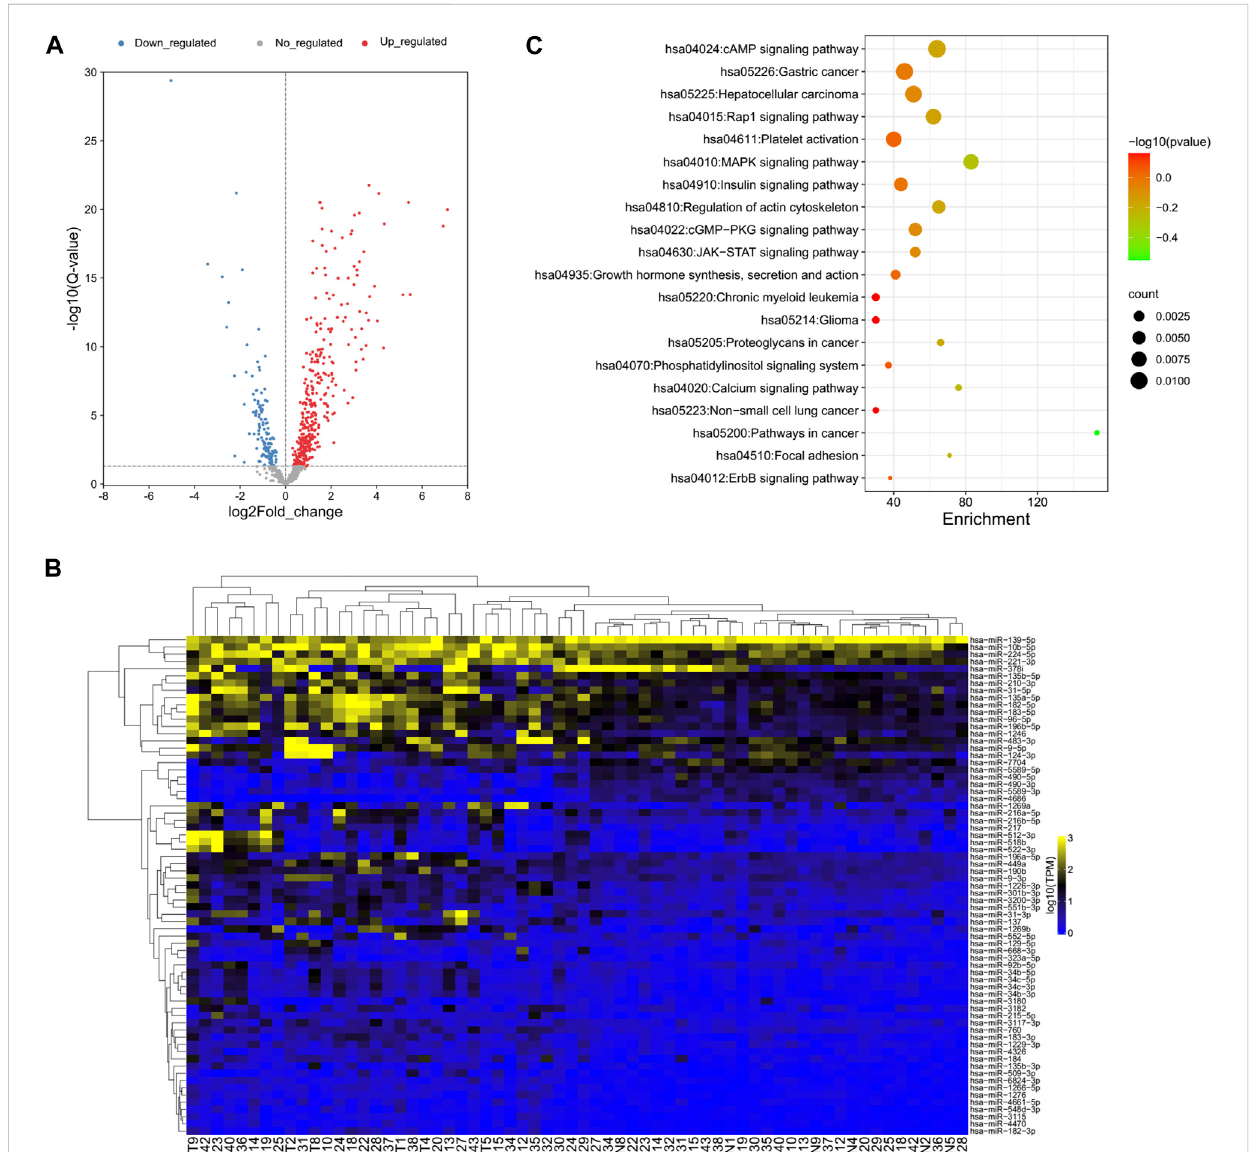
FIGURE 2 Global deep sequencing analysis of miRNAs from HCC tissue and normal adjacent tissue specimens. (A) Volcano plot of log2fold changes and -log10 (adjust p -value) differentially regulated miRNAs in HCC tissue and adjacent tissue specimens. Differentially expressed miRNAs were identi fi ed between all tumor and normal samples for each miRNA. (B) Unsupervised hierarchical clustering of differentially expressed miRNA expression from all patients. (C) Chart of top 20 enriched pathways of the target genes of differentially expressed miRNAs predicted by miRanda and